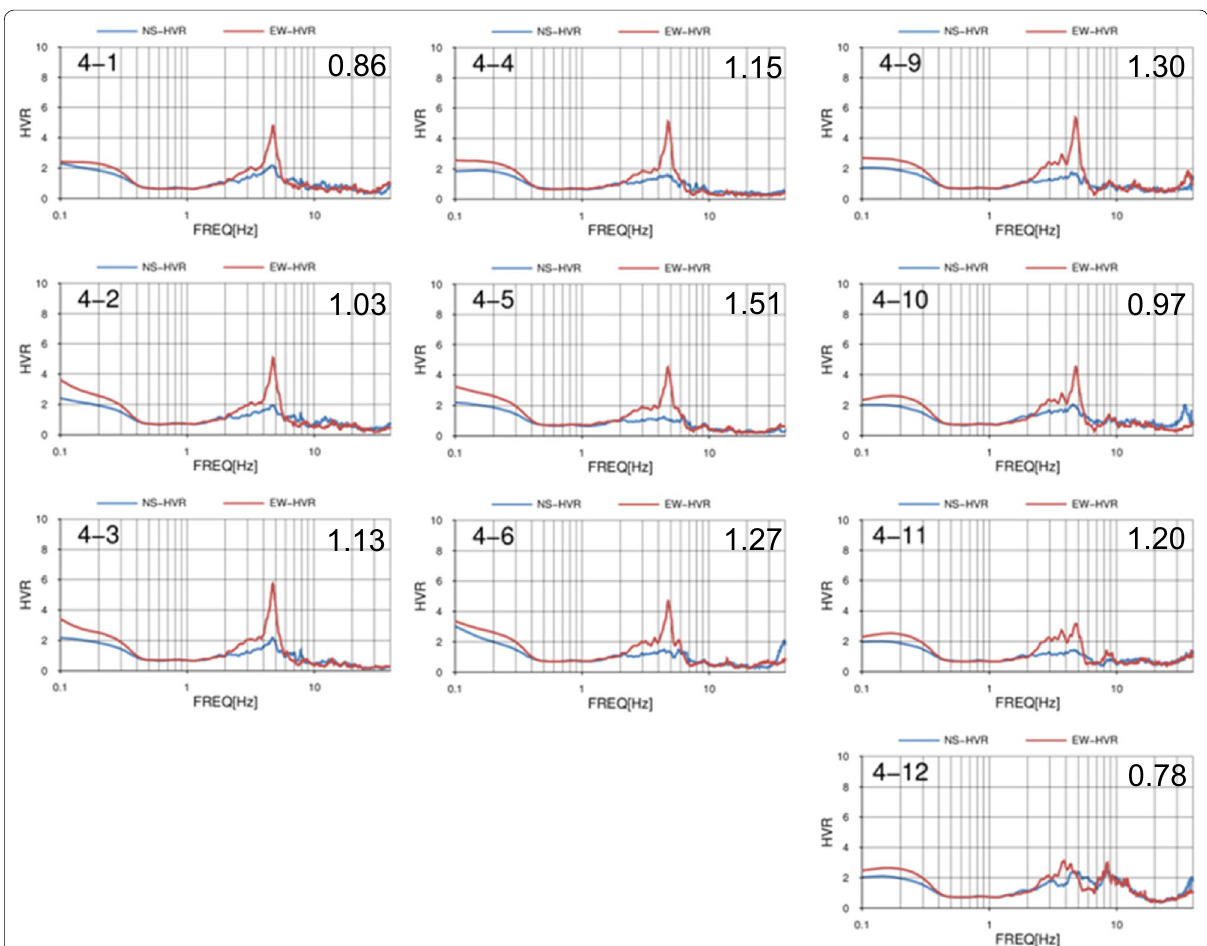
Fig. 5 Comparison of MHVRs along Line-4 shown in Fig. 2b. The figures from top-left to bottom-right are aligned from east to west on the survey line. Red and blue lines indicate NS/UD and EW/UD, respectively. The difference between the two is significant for points 4-1 to 4-11. The value of γ for each point is denoted in the right-top